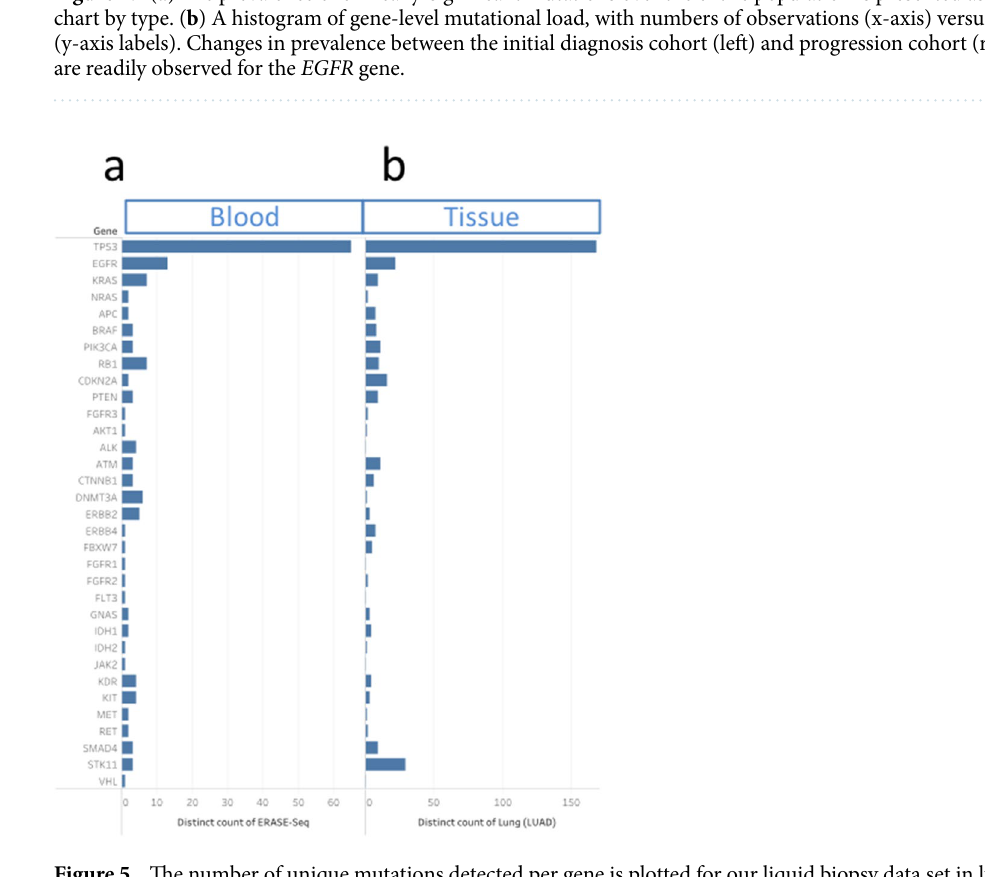
Figure 5. The number of unique mutations detected per gene is plotted for our liquid biopsy data set in lung ( a ) as compared to tissue-based cancer atlas (TCGA) data ( b ). The tissue data set analyzed in the TCGA cancer genome atlas were lung adenocarcinoma. The analysis was restricted to genomic regions covered by both tests, with the highest prevalence genes